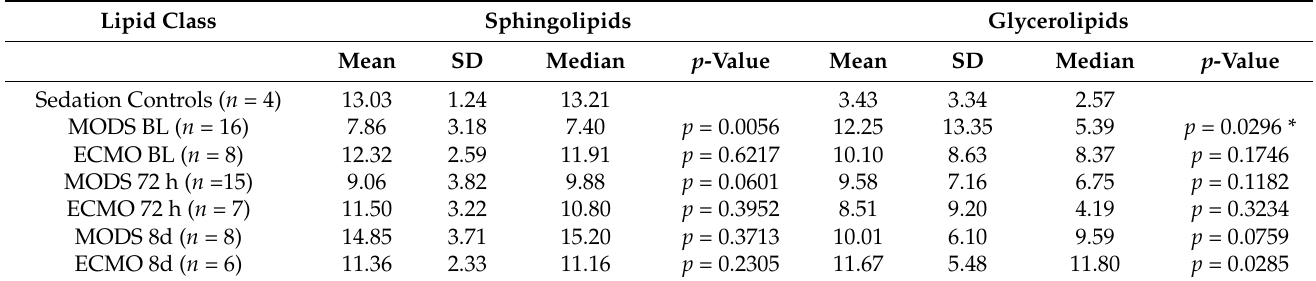
Table 1. Percent total of major lipid classes of MODS/ECMO Study 2016–2018 ( N =